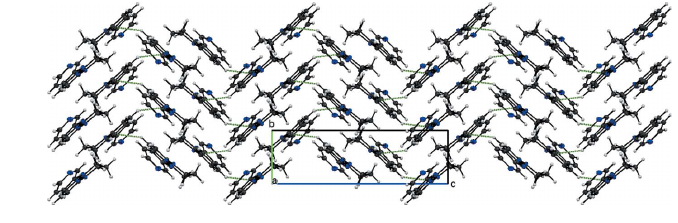
Figure 3 Infinite chains of compound I parallel to the a axis.